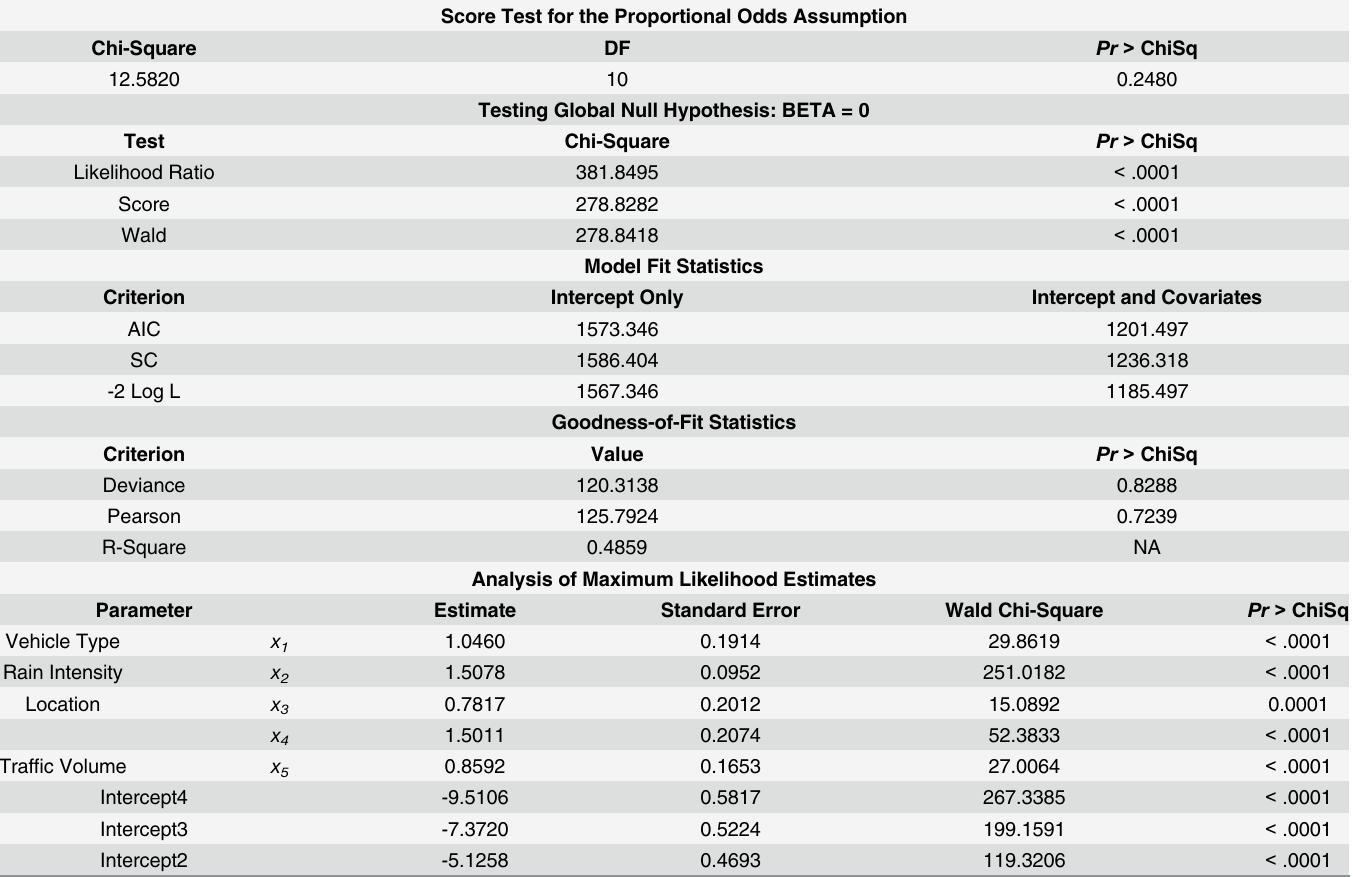
Table 4. Results of the ordered logit